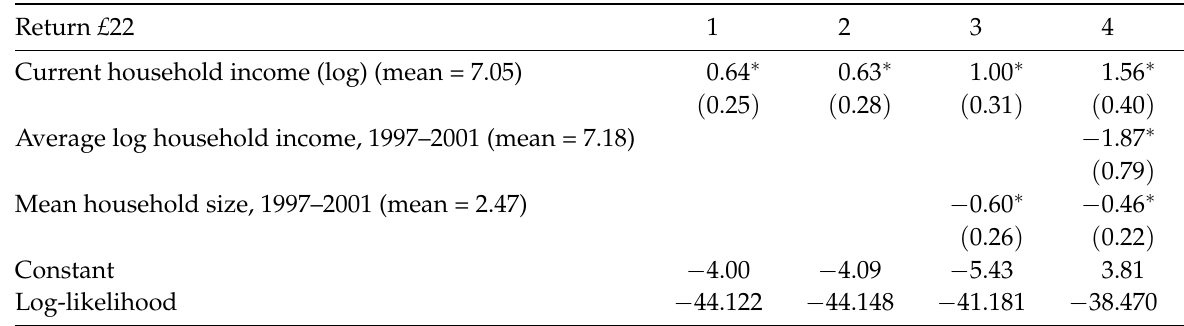
Table 1: Logit regression of impacts of current absolute income on trustworthiness. Return £ 22 1 2 3 4 Current household income (log) (mean =